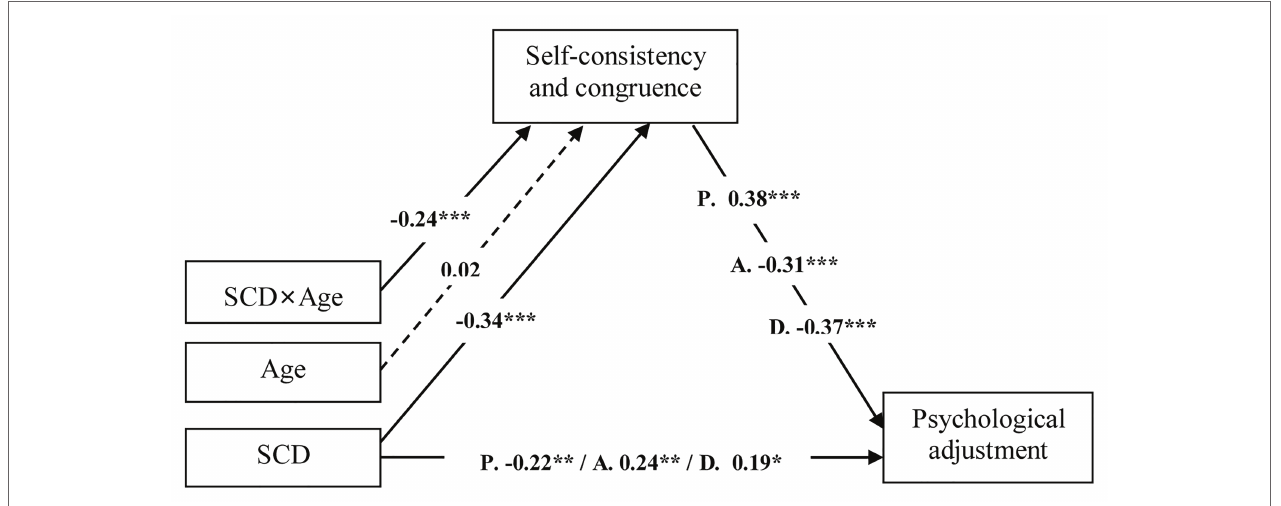
FIGURE 3 | Moderated mediation effect linking SCD and psychological adjustment. Path coefficients “P” were for analysis using psychological well-being as a response variable. Path coefficients “A” were for analysis using anxiety as a response variable. Path coefficients “D” were for analysis using depression as response variable. Solid lines indicate pathways with significant parameter estimates. Dashed line indicates nonsignificant pathway. SCD, self-concept differentiation; * p < 0.05, ** p < 0.01, *** p <